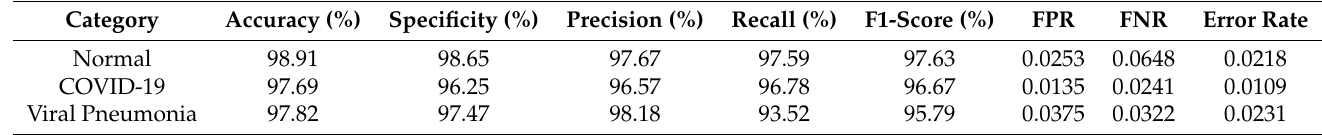
Table 5. Performance measures for VGG 16 after optimization for X-ray images.